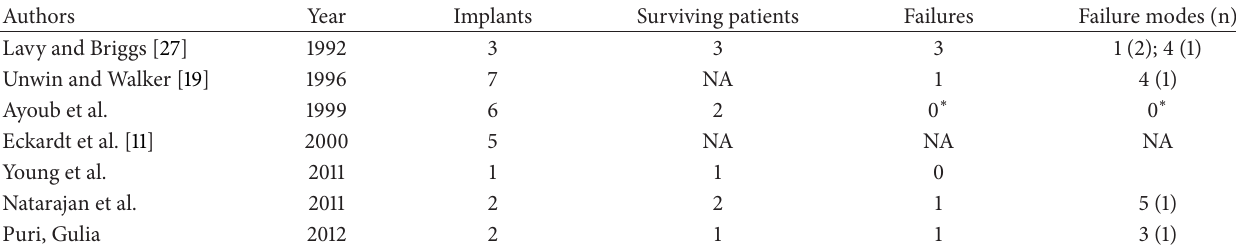
Table 2: Literature summary for expandable total humerus